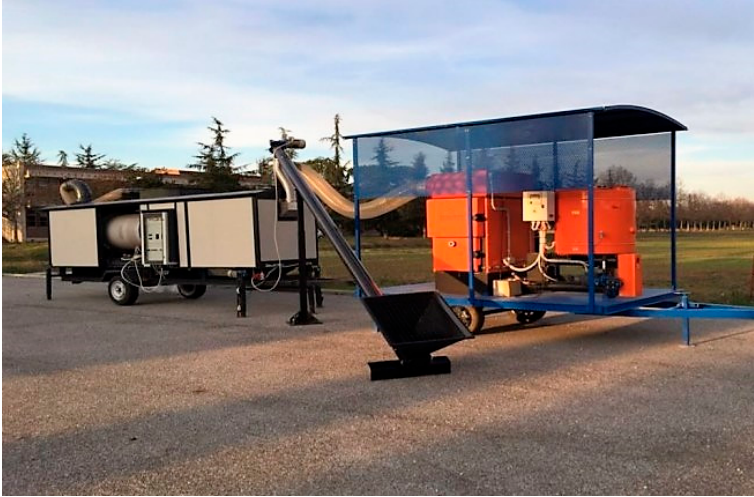
Figure 3. Mobile rotary dryer connected to a boiler of the power of 80 kW.